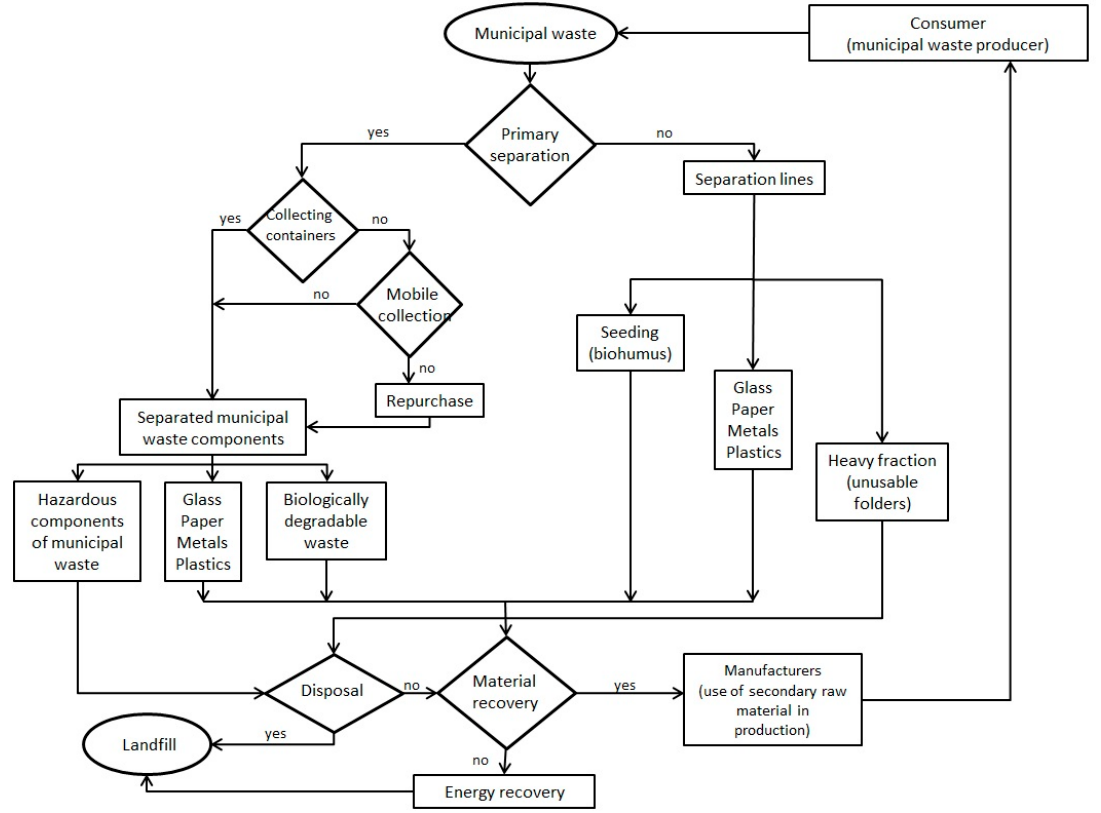
Figure 9. Proposal of implementation of Circular model into Municipal Waste Management . Source: Own processing.